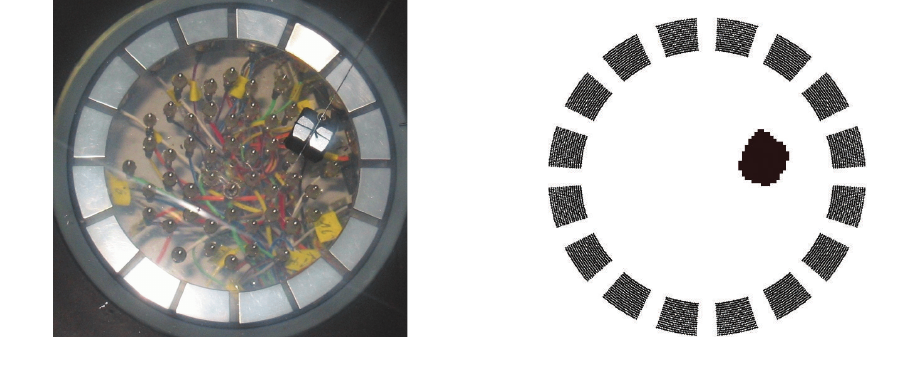
Figure 4: A first reconstruction.